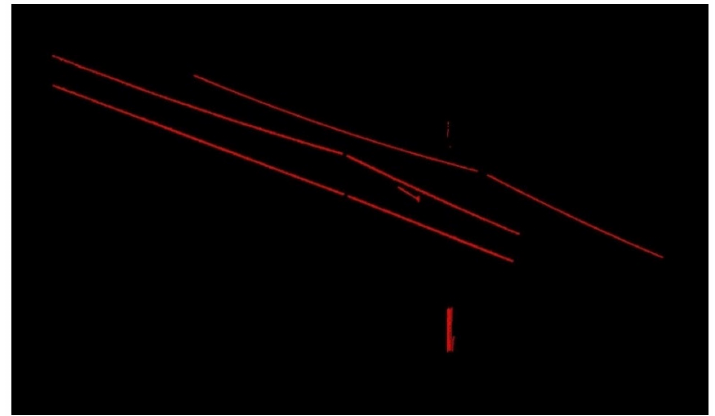
Figure 14. Experimental results of OCS with a length of 50 m.